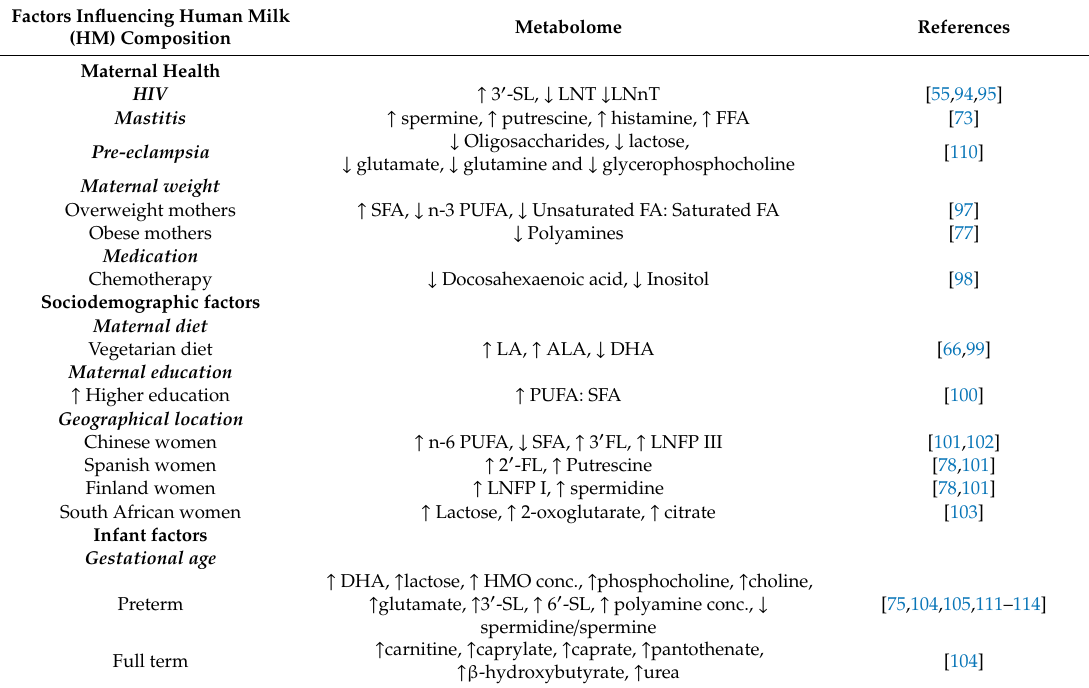
Table 3. Factors that may influence the human milk (HM)